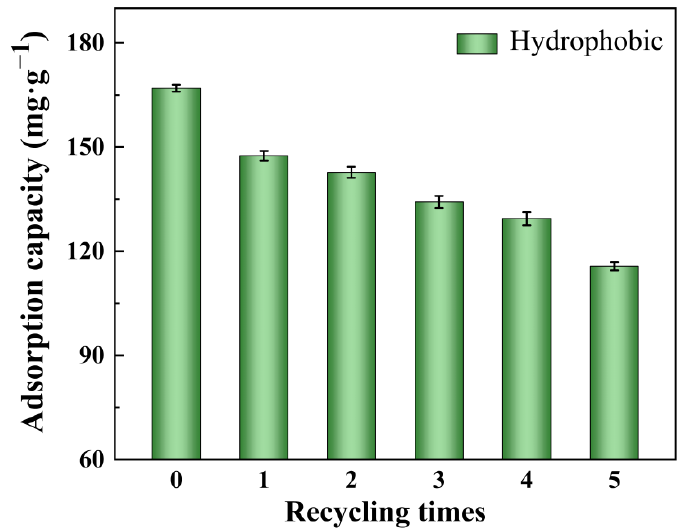
Figure 16. Recycling performance of hydrophobic ZrO 2 -SiO 2 xerogel at different recycling times.